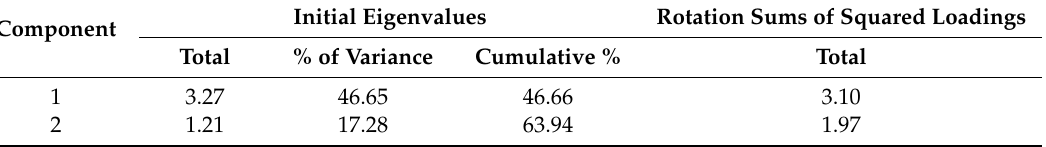
Table 1. Total Variance Explained-Exploratory Factor Analysis (EFA) for 7-items CAMM (using Valencia sample, n 1 = 360).